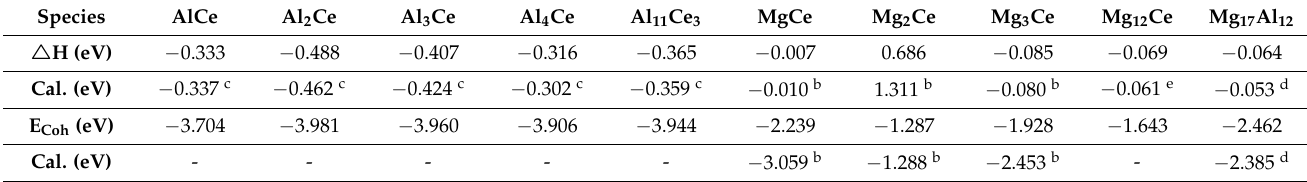
Table 4. E Coh and (cid:52) H of the possible second